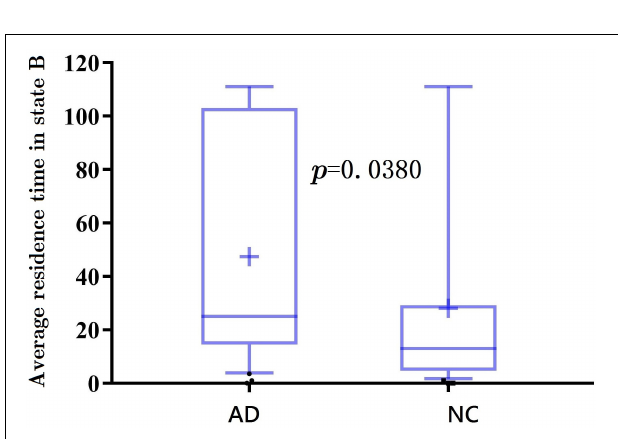
FIGURE 8 | The average residence time of spatiotemporal DMNs for AD and